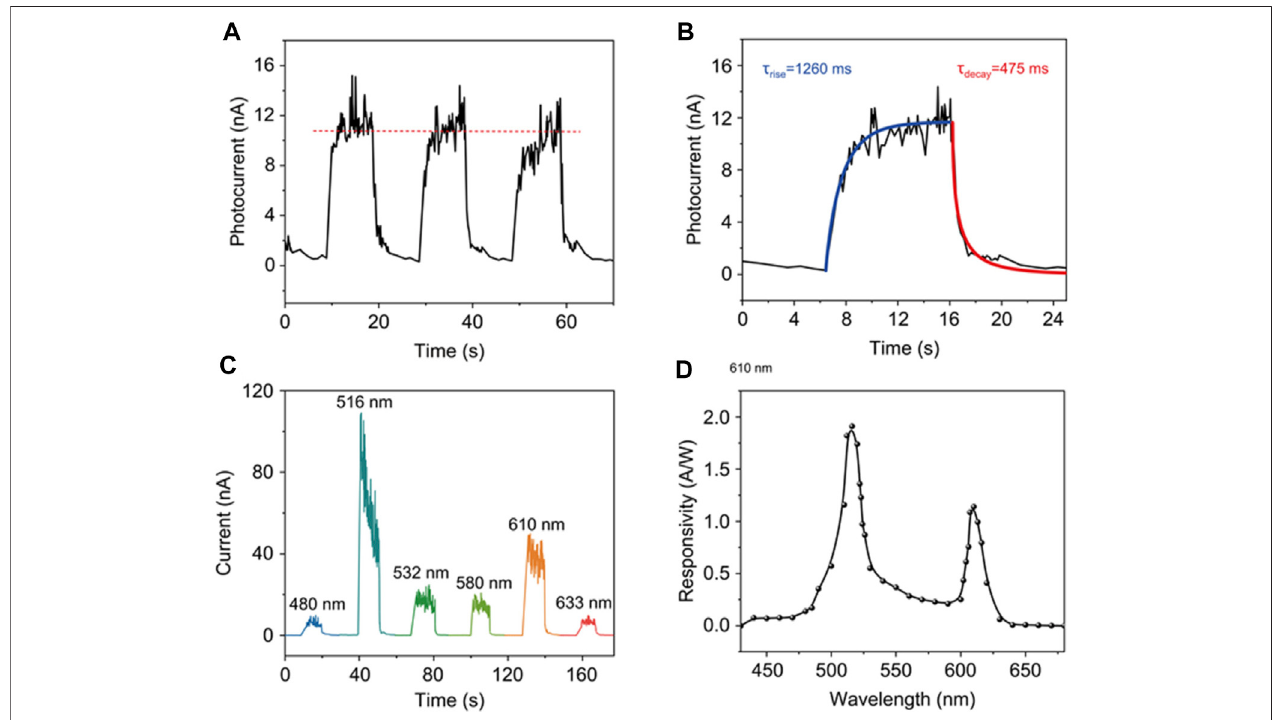
FIGURE 3| Time- and spectrum-resolved photoresponses ofthe MoTe 2 – WS 2 – MoTe 2 heterojunction device. (A) Photocurrents of the device in response tothree ON/OFF illumination cycles. The red dashed line suggests that the photocurrent maxima of the three cycles are the same. (B) Photocurrent of the device during one typical ON/OFF illumination cycle. Blue and red curves are fi tting results by assuming that the rise and decay processes of the photocurrent are exponential dependences. (C) Representative switching behaviors of the heterojunction device under illuminations at 480, 516, 532, 580, 610, and 633 nm. (D) Photocurrent spectrum of the heterojunction